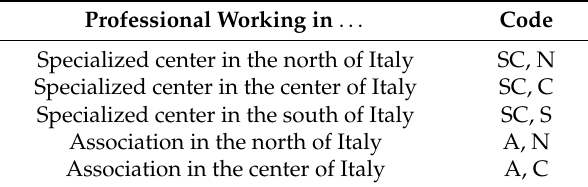
Table 2. Transcript codes for